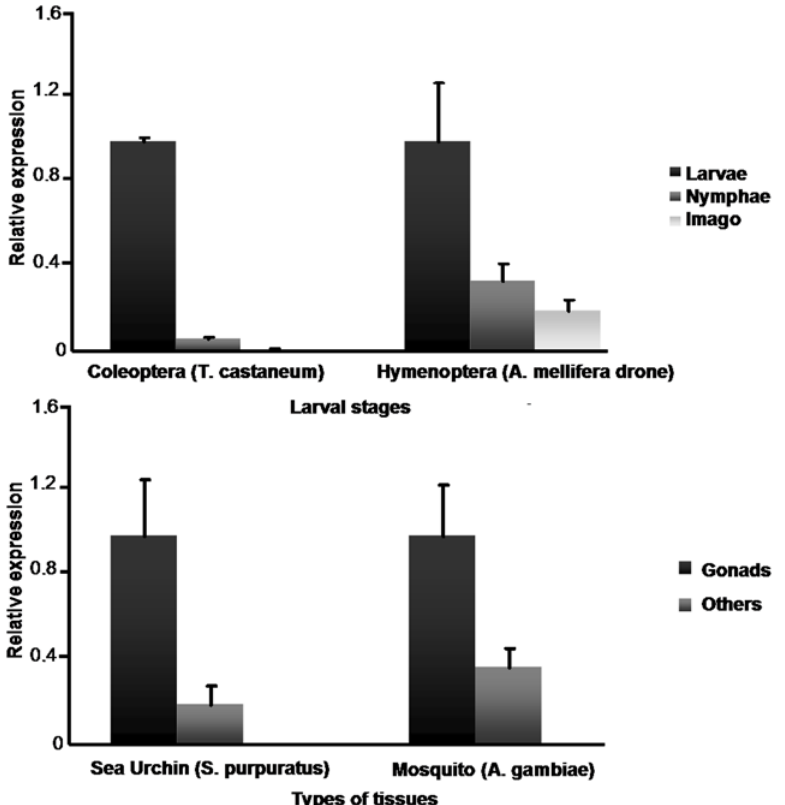
Figure 6. VKR are expressed in larvae and in gonads of adult insects and invertebrates Vkr transcripts were quantified in the different developmental stages of T.castaneum and of A.mellifera drone (A) and in tissues of A.gambiae and S.purpuratus (B). For graphical representation of qPCR data, cycle thresholds ( D Ct values) obtained for the different samples were deducted from the D Ct value obtained for larval stage (A) or gonad (B) transcript levels. Values were normalized as relative fold-difference using the D - D Ct ( DD Ct) method. Data are means 6 s.e. of triplicates from a typical experiment.